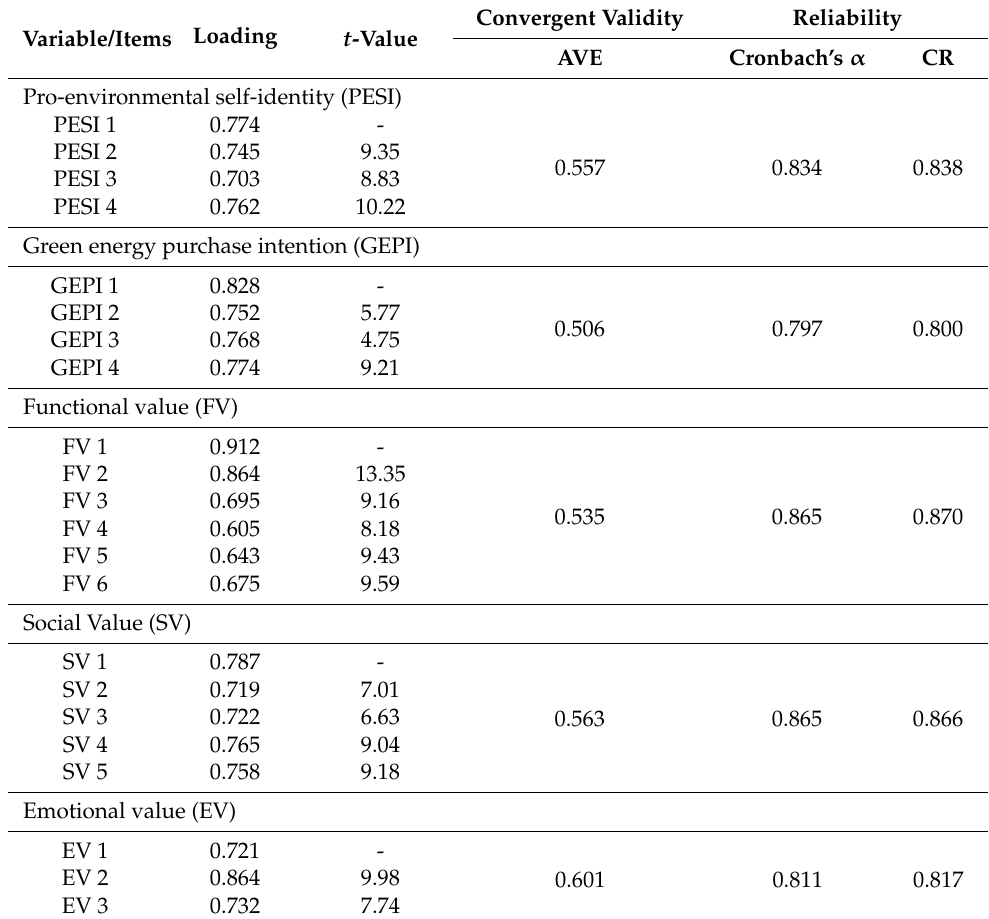
Table 2. The confirmatory factor analysis results.